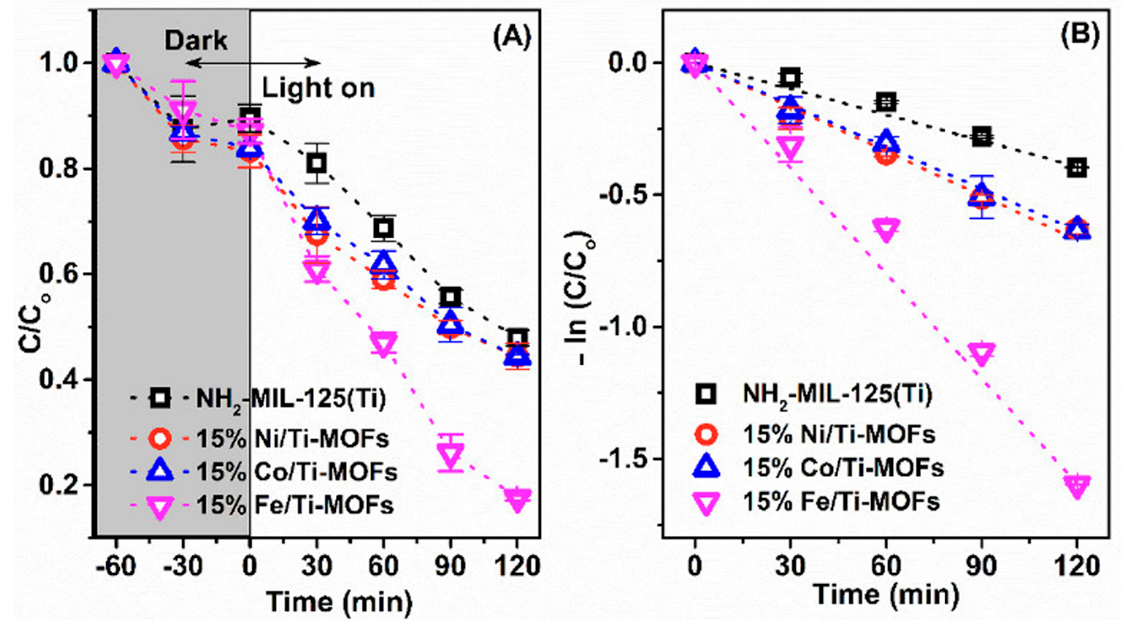
Figure 6. Removal efficiency of Rhodamine B using different photocatalysts under visible light irradiation with the aid of H 2 O 2 ( A ), and pseudo-first-order kinetic of degradation process ( B ). Reaction conditions: Rhodamine B 3.10 − 5 mg/L, H 2 O 2 2 mM, catalyst 5 mg.